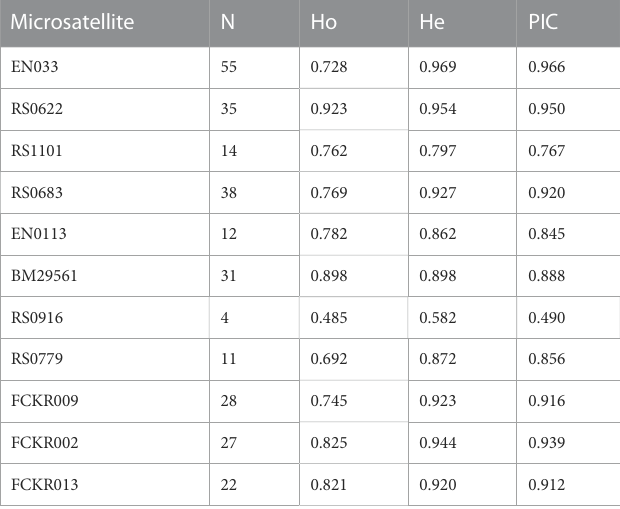
TABLE 3 Number of alleles (N), observed heterozygosity (Ho), expected heterozygosity (He), and polymorphism Information content (PIC) at 11 microsatellites.